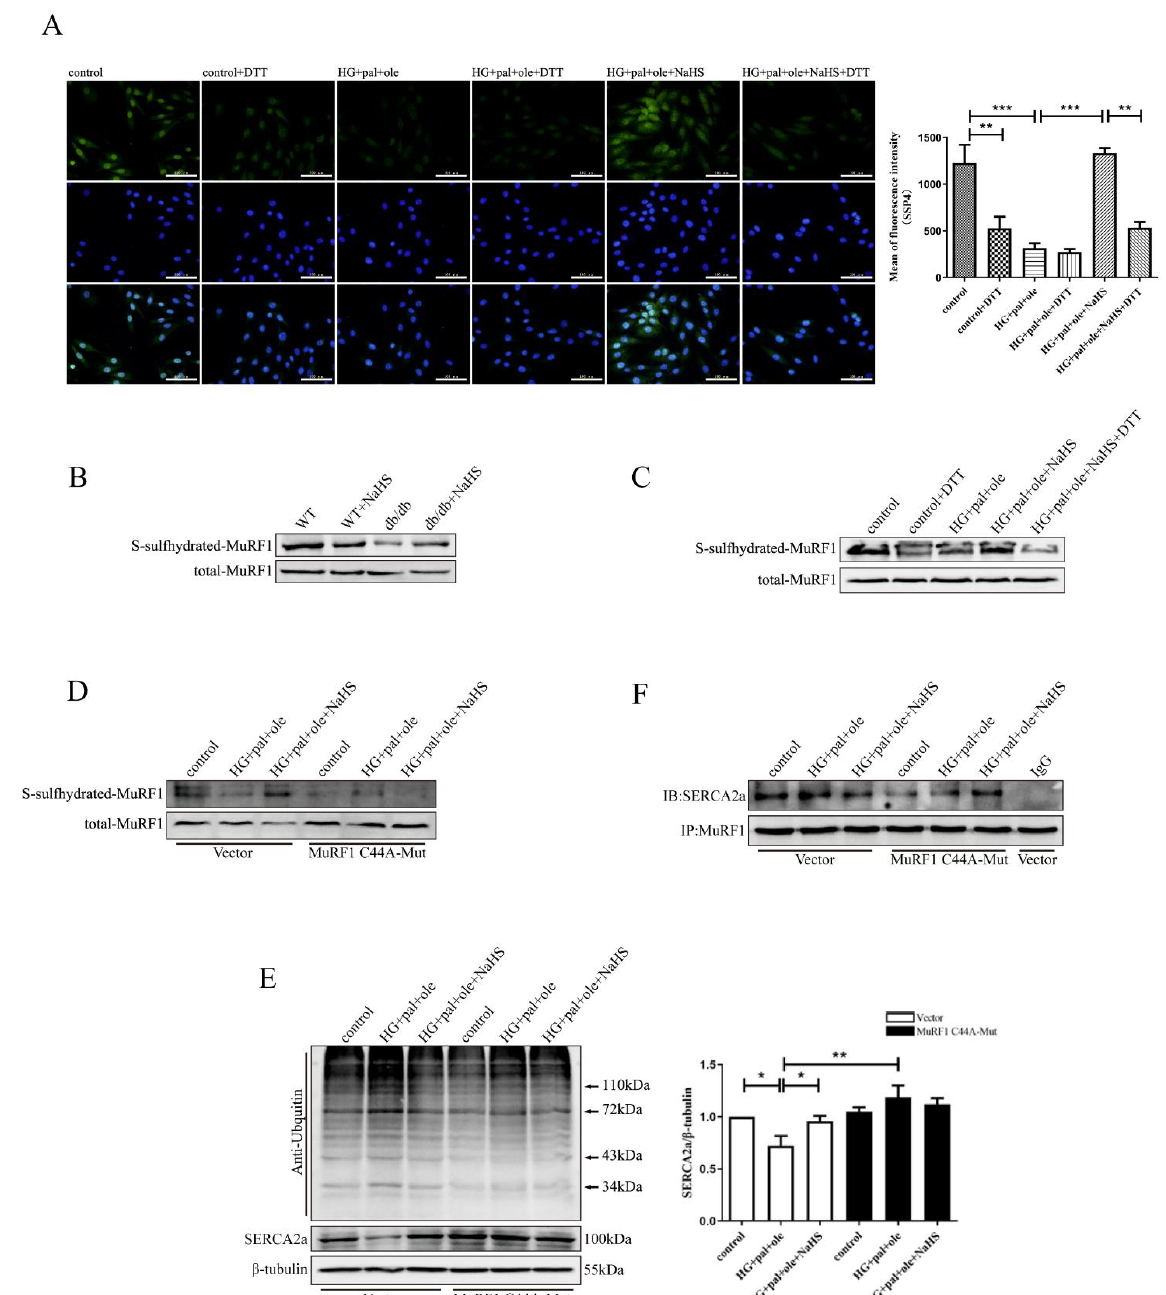
Figure 6. MuRF1 Cys44 site mutation increases SERCA2a protein content. ( A ) Detection of intracellular polysulfide levels in the NRCMs using fluorescent probe SSP4 ( n = 3). Scale bar: 100 μm. ( B ) The level of S-sulfhydration of MuRF1 in cardiac tissues was detected using the biotin switch method. ( C ) The level of S-sulfhydration of MuRF1 in the NRCMs was detected using the biotin switch method. After transfection with plasmids containing wild-type MuRF1 or MuRF1 mutated at Cys44 for 24 h, the NRCMs were treated with high glucose, palmitate, and oleate for 48 h in the presence or absence of NaHS. ( D ) The level of S-sulfhydration of MuRF1 in NRCMs after transfection was detected using the biotin switch method. ( E ) The expression of Ubiquitin and SERCA2a ( n = 5) was assessed by Western blotting in the NRCMs after transfection. ( F ) The NRCMs after transfection were immunoprecipitated with anti-MuRF1 antibody and then immunoblotted with antibodies specific for SERCA2a. All values are presented as means ± standard errors, * p < 0.05, ** p < 0.01, *** p < 0.001.